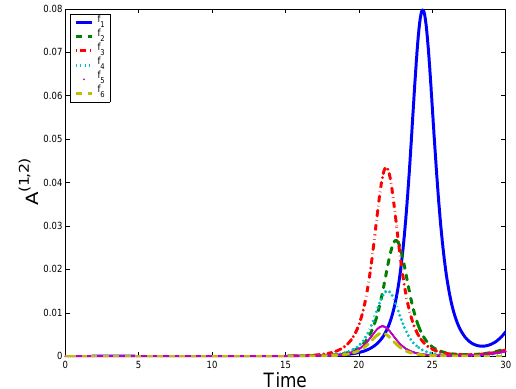
(t) for each f i i